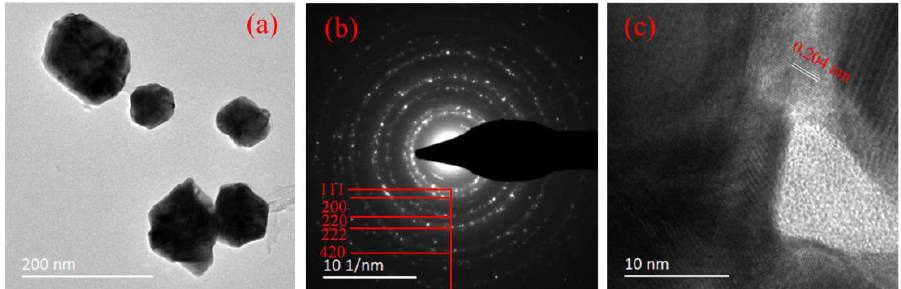
Figure 8. ( a ) TEM images of AuNP produced with a HAuCl 4 /sodium citrate ratio of 1:3 with pulsed plasma treatment for 7 min. ( b ) SAED pattern of an ensemble of AuNP. ( c ) high-resolution TEM (HRTEM) image of a typical single crystal of AuNP.